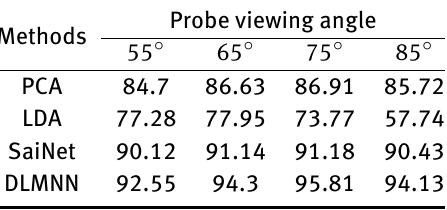
Table 4: The recognition rates (%) of different methods in no-variation condition evaluated on OU-ISIR-LP.